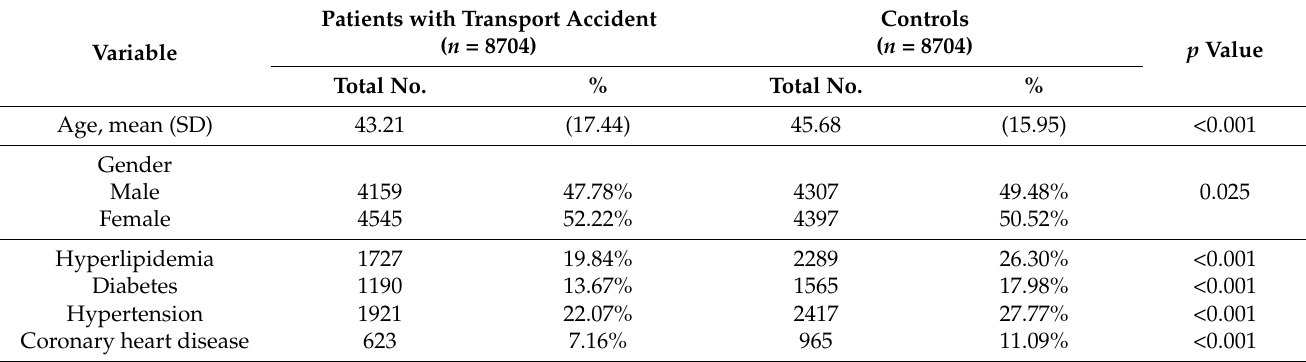
Table 1. Demographic characteristics of patients diagnosed with transport accident during 2017 and control patients in Taiwan ( n =